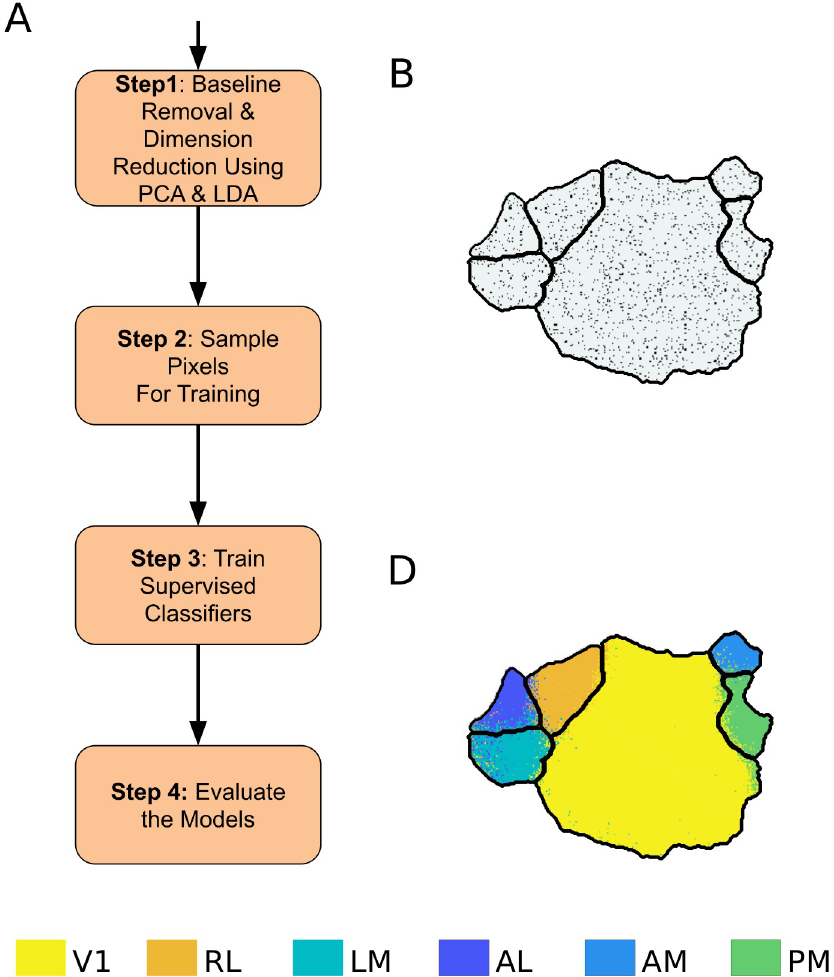
Fig 2. Pipeline for supervised classification of visual areas. A ) Block diagram for supervised classification of visual cortex. B ) The pixels chosen for training the classifiers are shown as black dots. C ) Result of classifying visual cortex using the supervised GMM classifier. Boundaries in black denote the ground